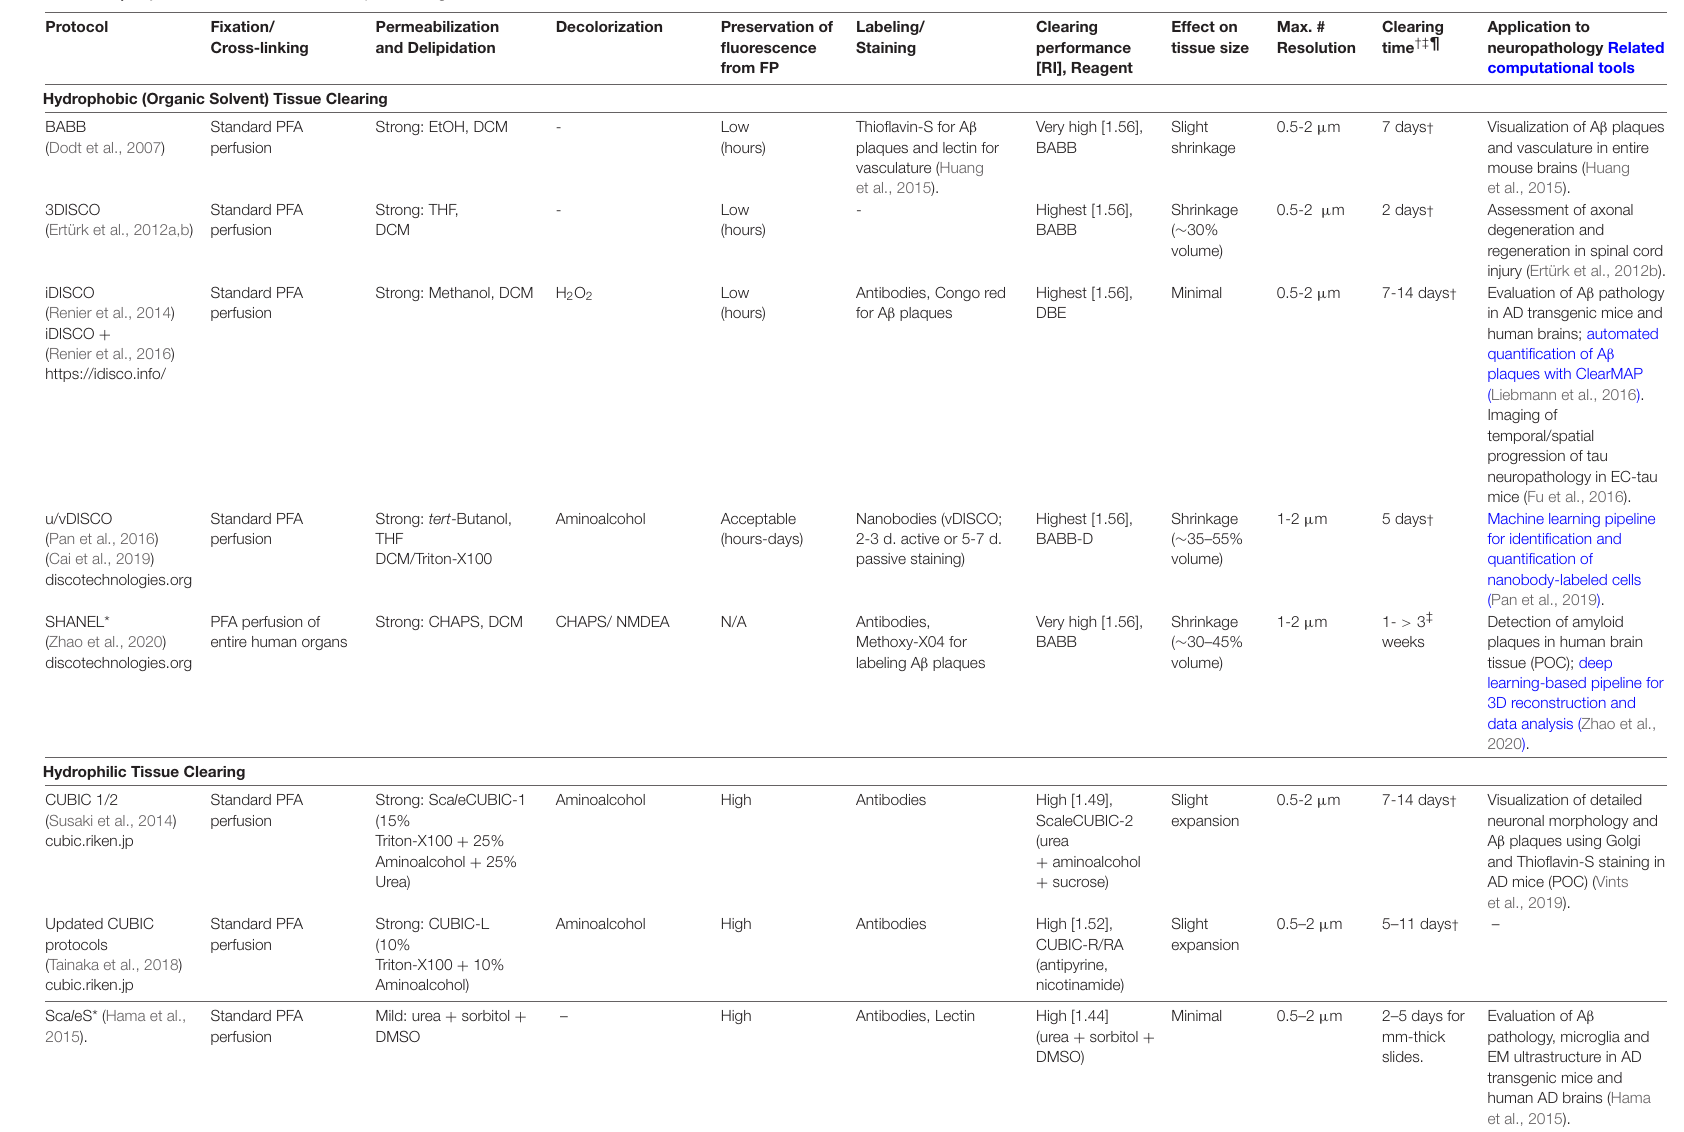
TABLE 1 | Key features of the main tissue processing methods discussed.